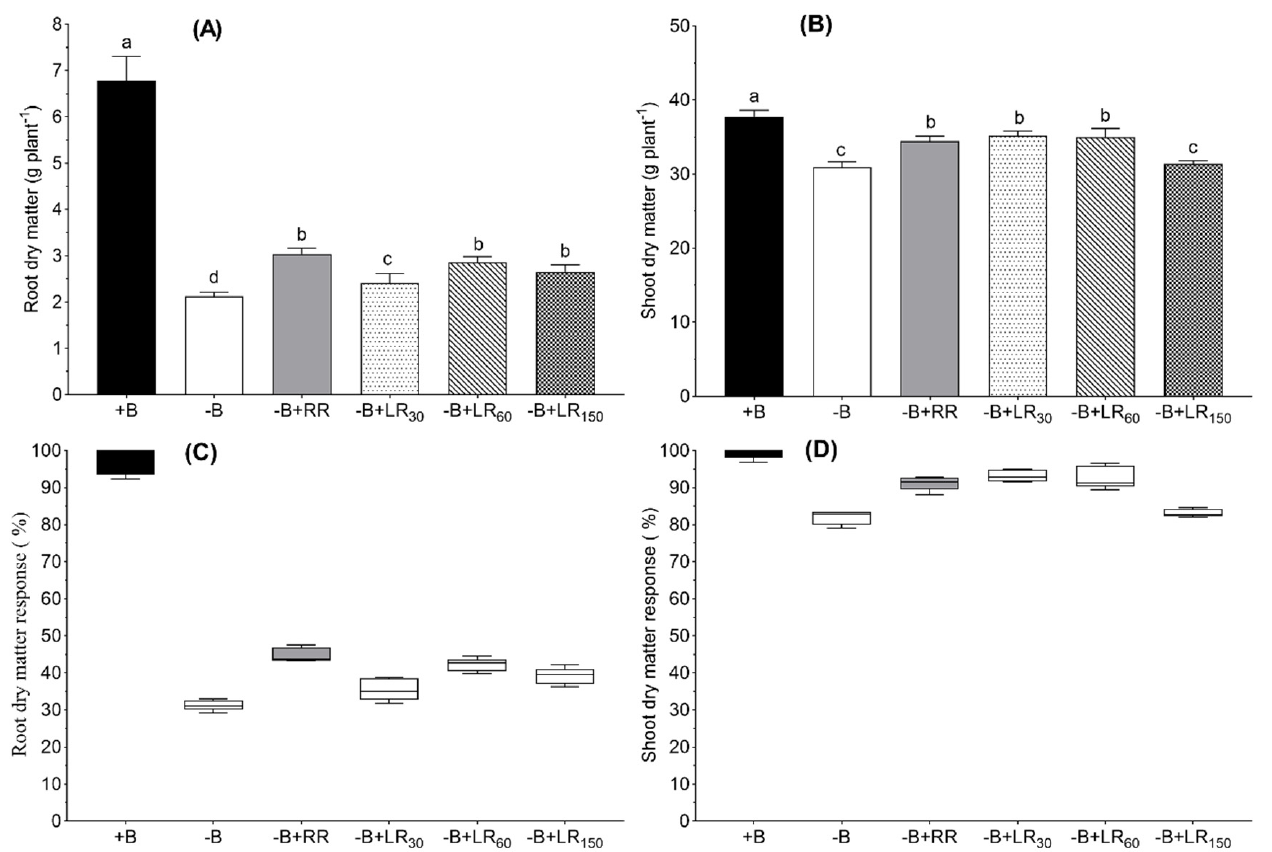
Figure 2. Root ( A, C ) and shoot ( B, D ) dry matters and their responses to different B treatments in nutrient solution grown Brassica napus for 42 days. +B, 25 µ M B in NS; − B, 0.25 µ M B in NS; − B+RR, 0.25 µ M B in NS for the first two weeks and then 25 µ M B for the latter two weeks; − B+LR 30 , 0.25 µ M B in NS and foliar-applied 30 mM B at two weeks; − B+LR 60 , 0.25 µ M B in NS and foliar-applied 60 mM B at two weeks; − B+LR 150 , 0.25 µ M B in NS and foliar-applied 150 mM B at two weeks. The data ± SE are means of five independent pot replicates. Different letters on bars indicate significant differences between treatments (ANOVA with Duncan’s multiple range test p ≤